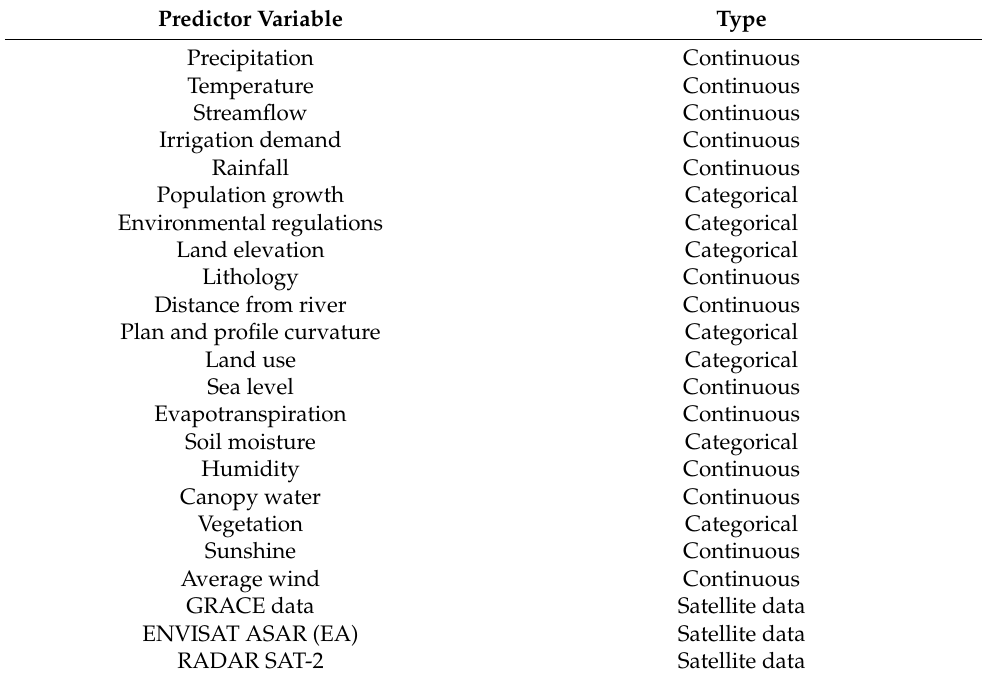
Table 4. Common predictor variables from the primary